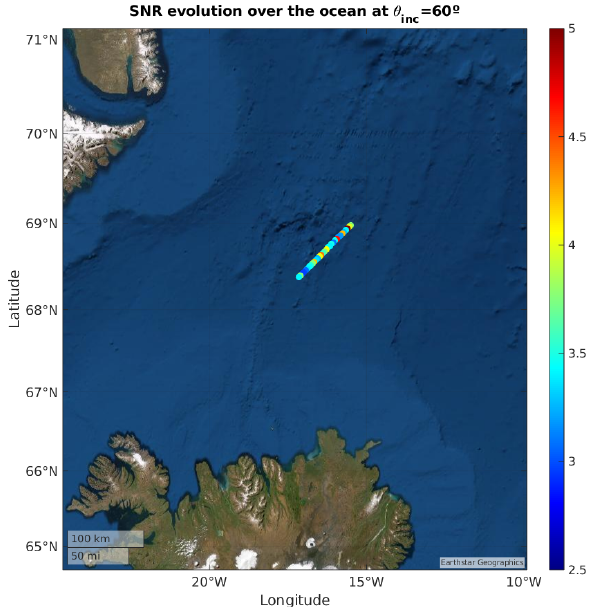
Figure 15. SNR evolution (dB) for a selected track near Iceland, collected on the 10 October 2020.